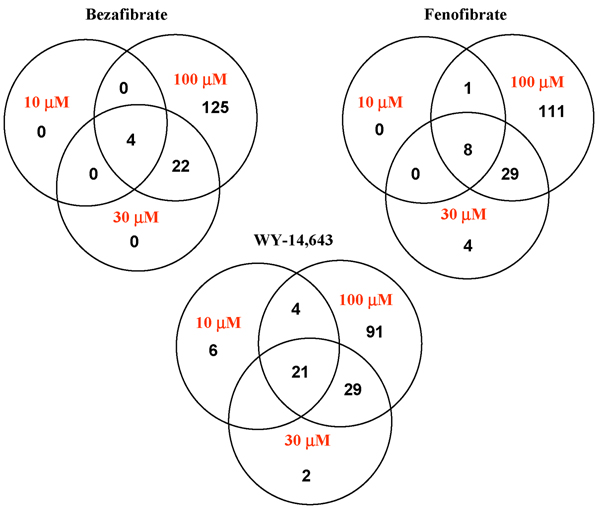
Numbers of genes regulated by drug treatments. Numbers of significant genes (FC > 1.5, P < 0.05) regulated by bezafibrate, fenofibrate and WY-14,643 at the various concentrations of 10, 30 and 100 μM. Numbers of genes commonly regulated at low, middle and high dose are presented in Venn diagram.